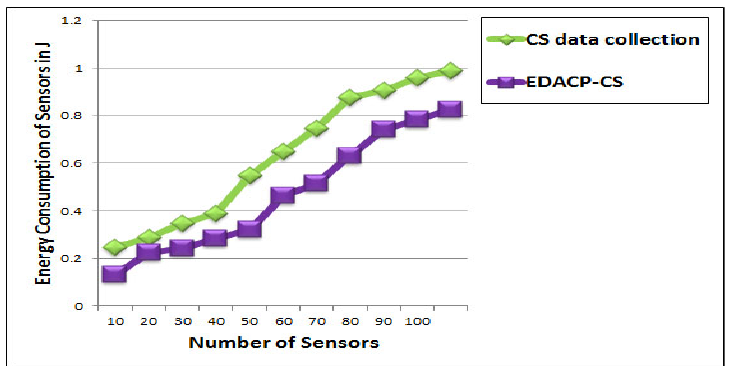
Figure 7. Energy consumption for the wireless sensor networks (WSN).